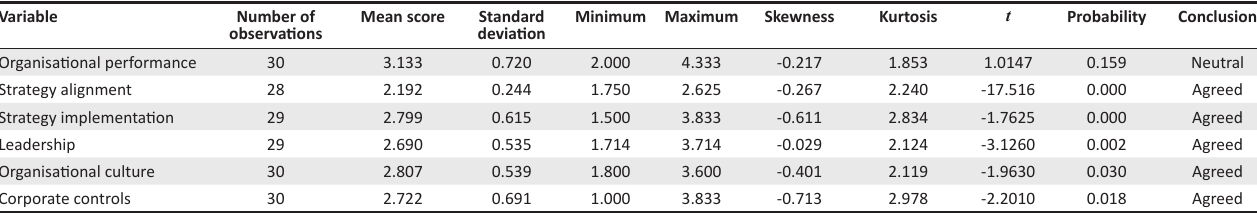
TABLE 3: Descriptive statistics of key constructs